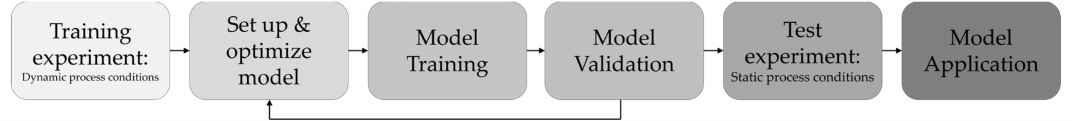
Figure 2. Flowchart of the hybrid model methodology for application in crossflow